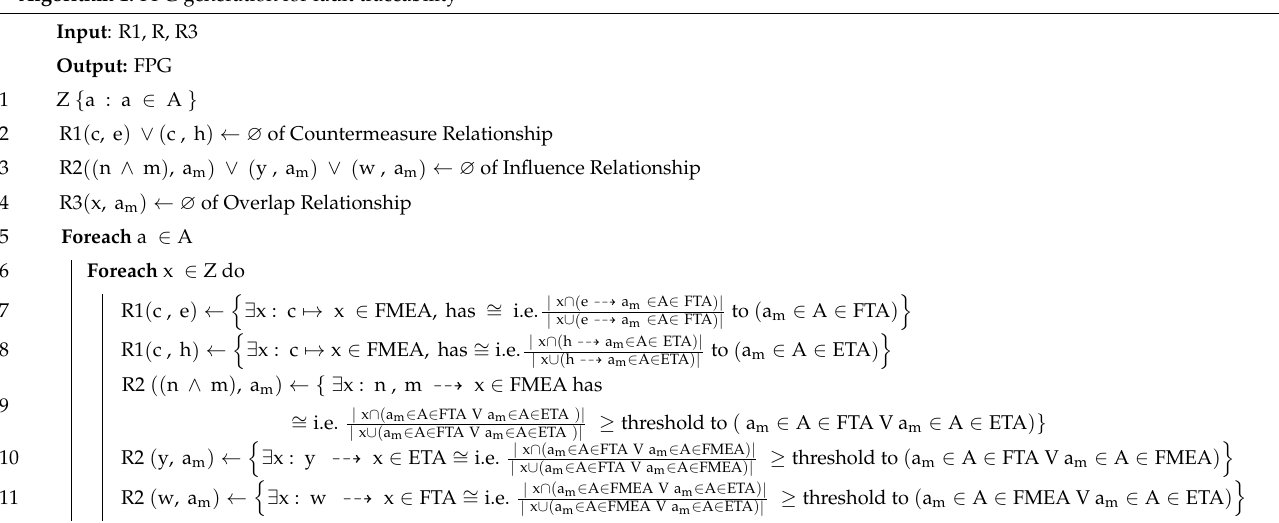
Algorithm 1: FPG generation for fault